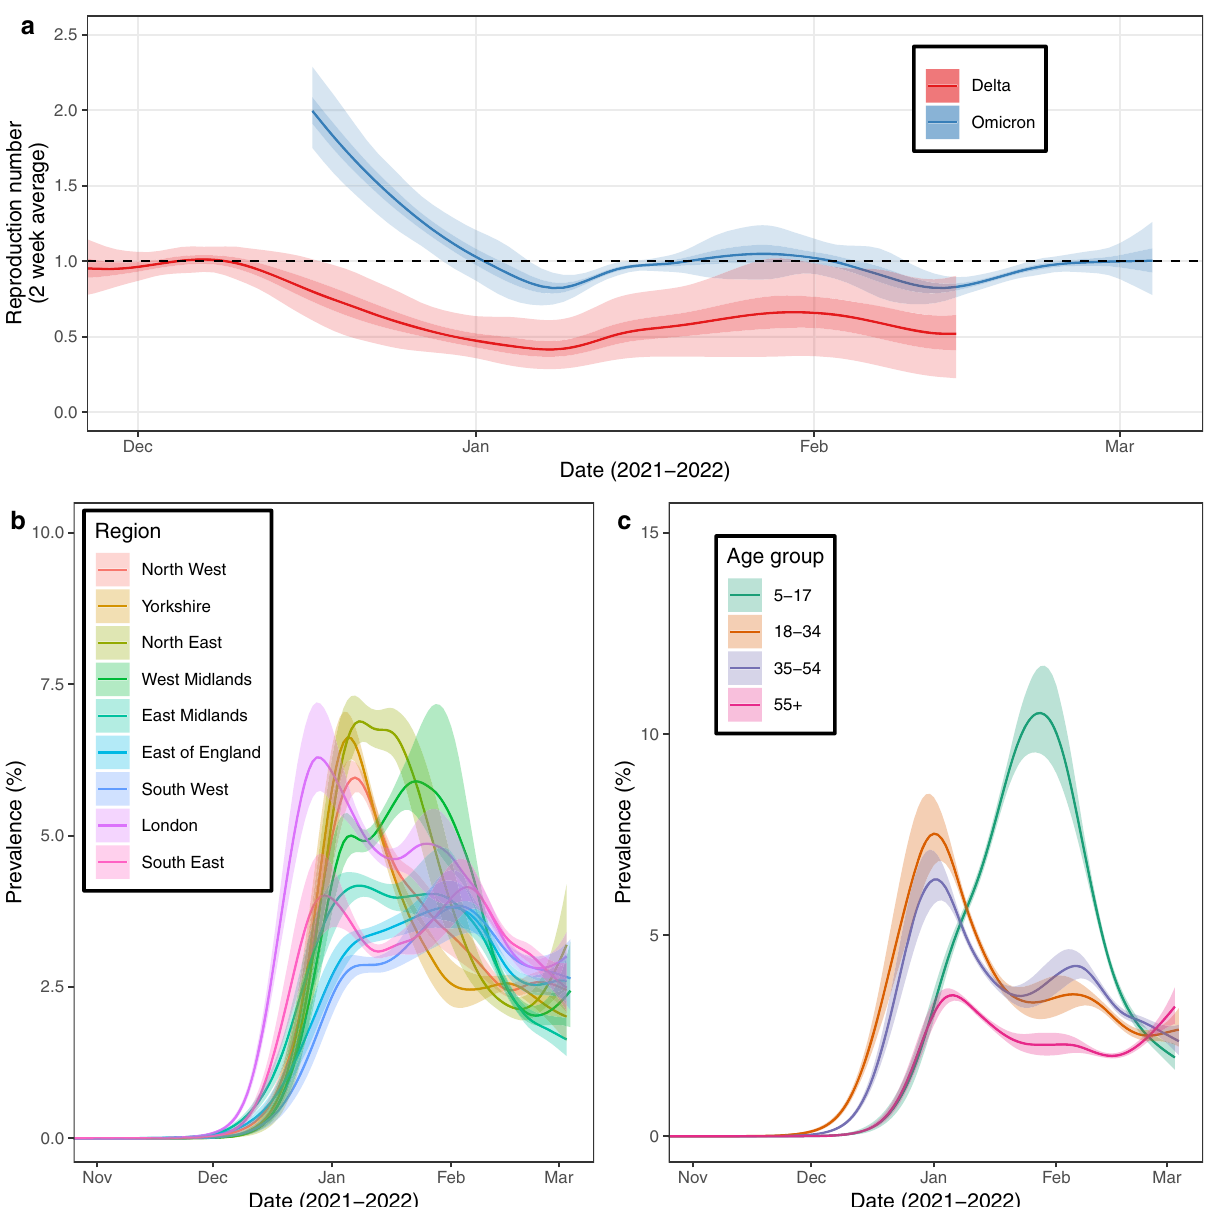
estimate (solid line) and 50% (shaded region) credible intervals. 95% credible intervals and daily point estimates are included in Supplementary fi gure 1. c Mod- elled prevalence of Omicron for four age-groups in England, estimated using a mixed-effectsBayesianP-splinemodel.Estimatesareshownwithacentralestimate (solid line) and 50% (shaded region) credible intervals. 95% credible intervals and daily point estimates are included in supplementary fi gure